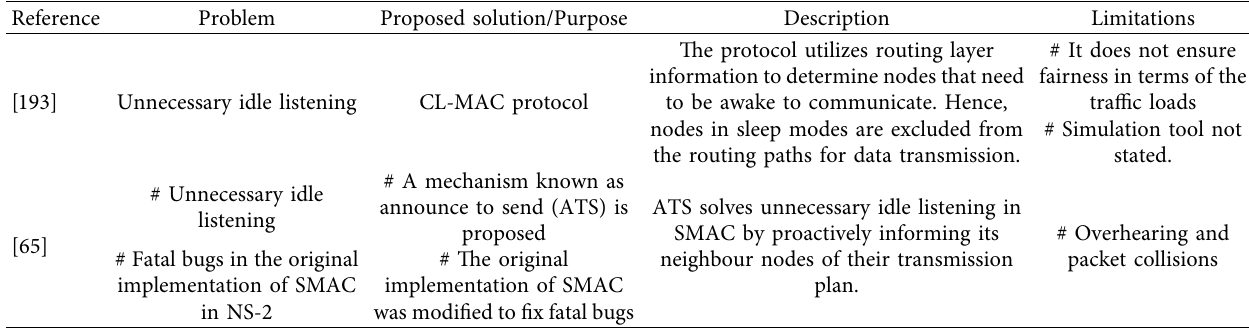
Table 9: Proposed protocols/algorithms for mitigating unnecessary idle listening in SMAC protocol.